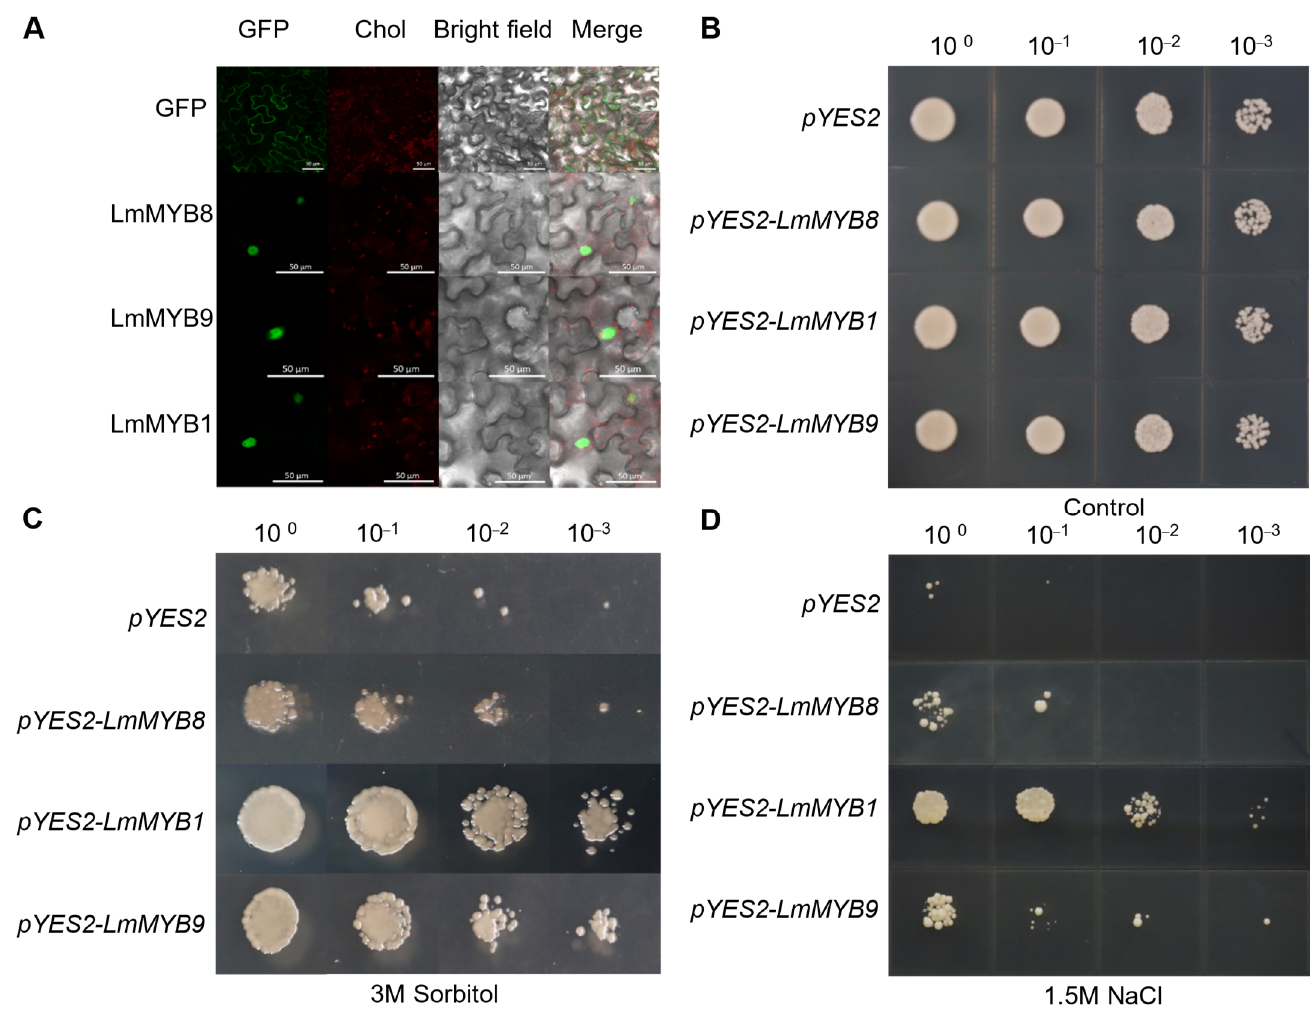
Figure 7. LmMYB transcripts are localized to the nucleus and enhanced drought and salt tolerance in yeast. ( A ) Subcellular localization of LmMYB1 , LmMYB8 and LmMYB9 ; scale bar, 50 µ m. ( B – D ) The growth of yeast transformed with the empty vector pYES2 or with pYES harbouring LmMYB1 , LmMYB8 or LmMYB9 under control, 3 M sorbitol and 1.5 M NaCl conditions.